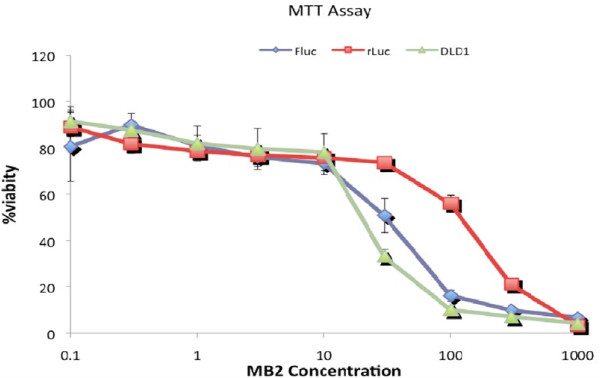
MTT assay result; The effects of MB2 on DLD-1, DLD1/SV-rLuc, and DLD1/SV-FLuc cells exposed to serial dilution of MB2 ranging from .1 ηM to 1 μM for 96 hours showing gradual decrease in % viability with the increasing dose of MB2. Absorbance values were blanked against DMSO and the absorbance of cells exposed to medium only (i.e. no drug added) was taken as 100% cell viability.